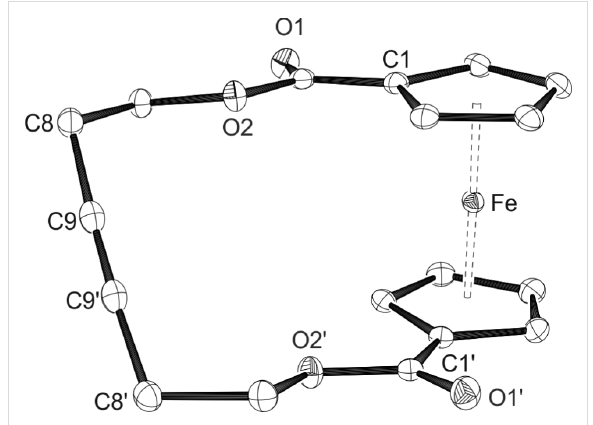
Figure 5: ORTEP diagram of 2a with thermal displacement parame- ters drawn at 50% probability; hydrogen atoms are omitted for clarity. Selected bond lengths [Å] and angles [°]: Fe–Ct 1.6414(6), Ct–Fe–Ct’ 178.809(1), C9–C9‘ 1.193(2), C8–C9–C9‘ 172.1(2).